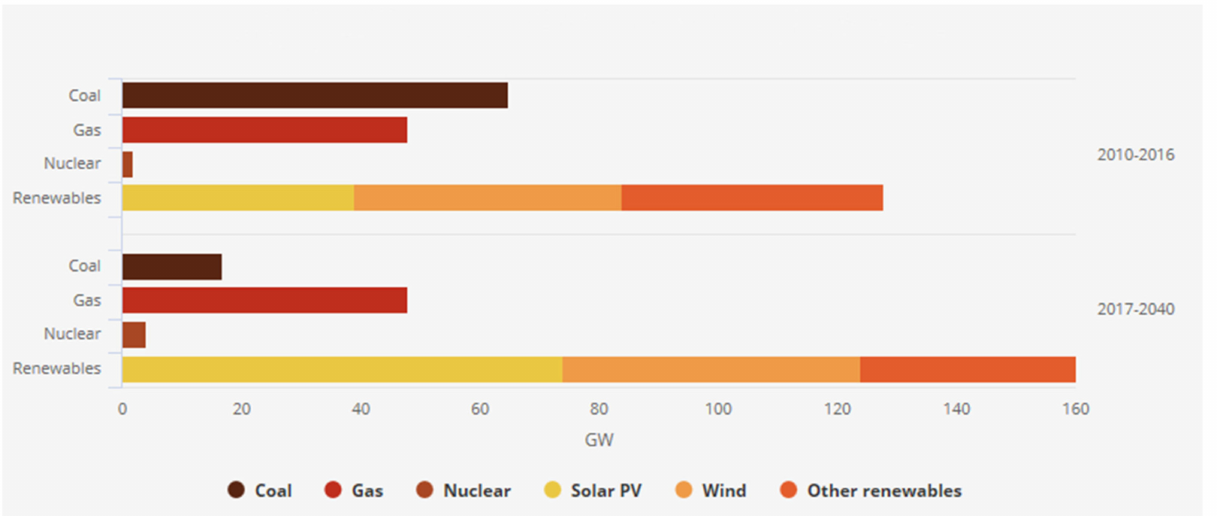
Figure 11. World annual average increase -in GW- of the main energy sources [32].